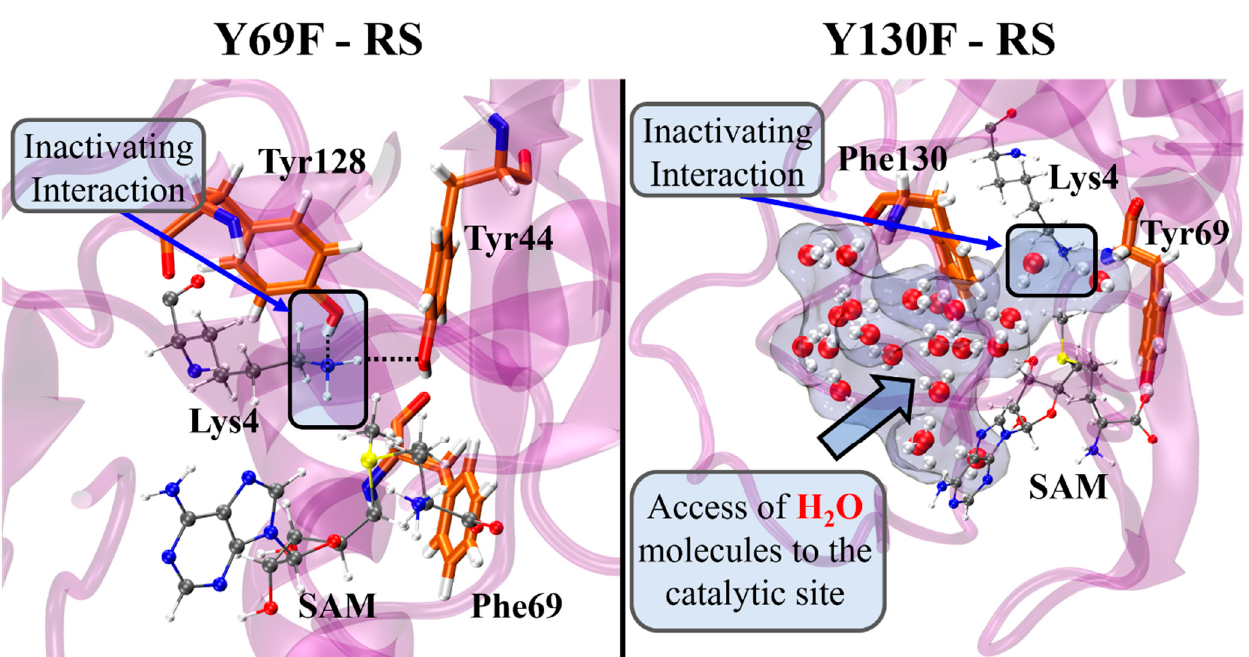
Figure 2. Structural representation of the inactivation mechanism of Y69F and Y130F mutants. ( Left ) The Y69F mutation leads to a conformational change of K4 that leads to the interaction of Y128 with the electron pair from N ε K4 inactivating the substrate. ( Right ) The Y130 mutation opens a cavity between Y130 and SAM cofactor, which allows the access of water molecules to the catalytic site, where one molecule sequesters the electron pair from N ε K4 avoiding Met attack.